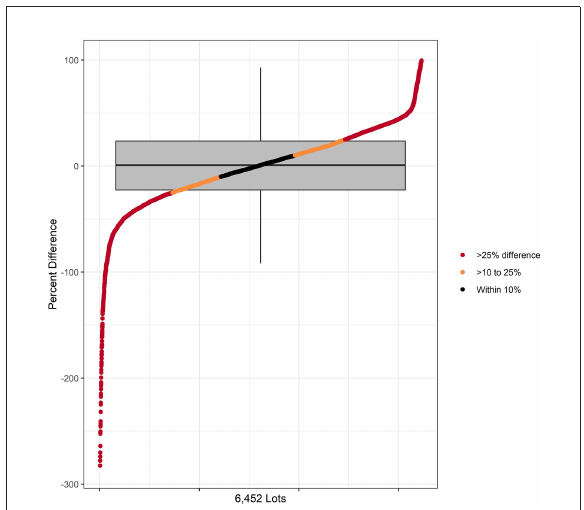
FIGURE4 Comparison of Reg and nDCD at the lot level with the difference expressed as the percentage of Reg for each lot. The distribution on the X axis represents the values for 6,452 lots after 8 lots were omitted for truncation of the Y axis. Data are reported as both a distribution and as a box and whiskers plot. The box and whisker plot corresponds only to Y axis values for percent difference.